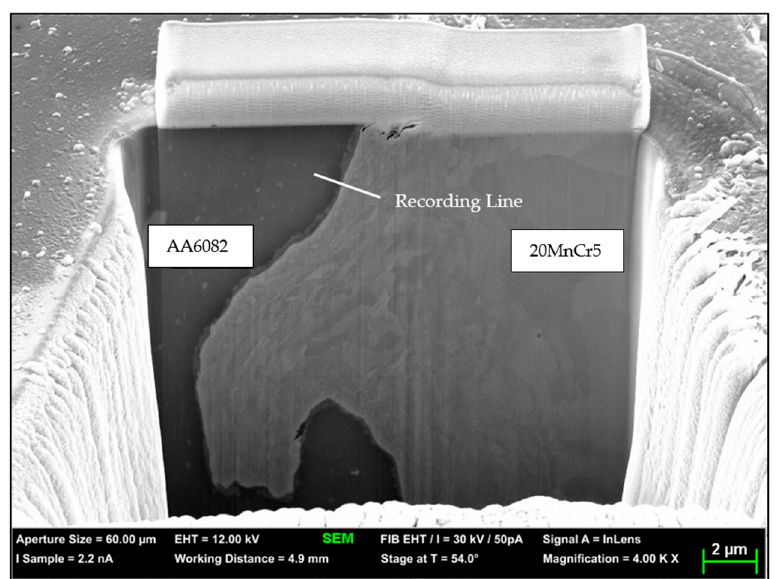
Figure 14. Scanning electron microscopy (SEM) image of a cross section prepared by a focused ion beam (FIB) in-lens detector (sample of Geometry C).